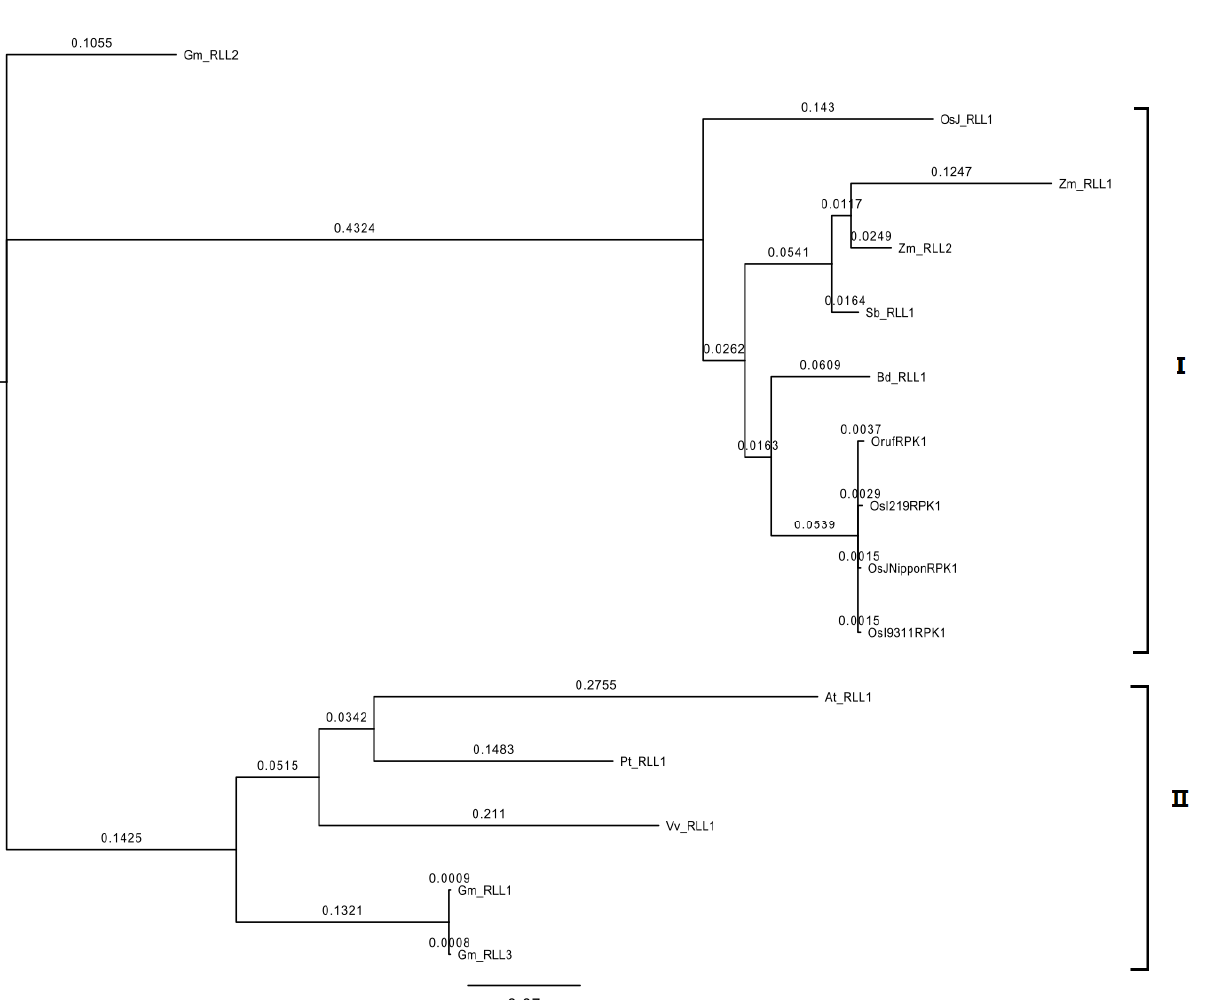
Figure 4. Cluster analysis of OrufRPK1 and orthologous plant RPK1 genes. The phylogenetic tree was constructed using maximum likelihood (MrBayes 3.2.0).